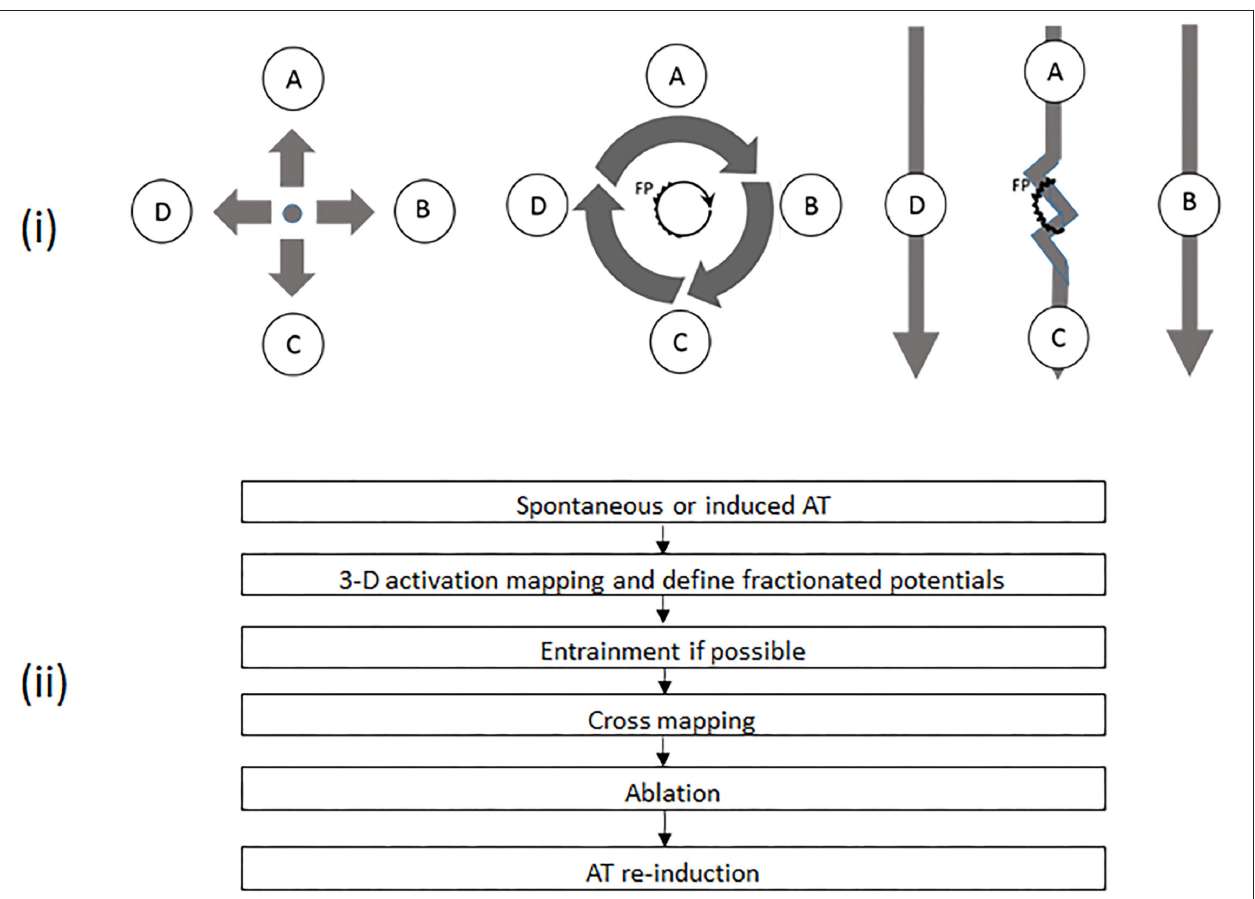
FIGURE 1 | (i) Schematic diagrams demonstrating different activation patterns in various atrial tachycardias (ATs) and the principles of cross-mapping for the differentiation of different ATs with fractionated potentials (FPs). The left panel shows a focal AT with sites A, B, C, and D activated almost at the same time. The middle panel demonstrates a microreentrant AT, with sites A, B, C, and D activated sequentially. The core with a FP is the source for maintenance of tachycardia. In the right panel, FP is a bystander potential. Thus, Sites A and C are activated sequentially due to slow conduction through FP. Sites B and D are activated almost simultaneously. The twisted line represents an area with FP. The heavy arrow shows the direction of activation. A, B, C, and D represent mapping sites around an FP, respectively. (ii) Workflow chart of mapping and ablation. AT,atrial tachycardia; FP, fractionated potential.